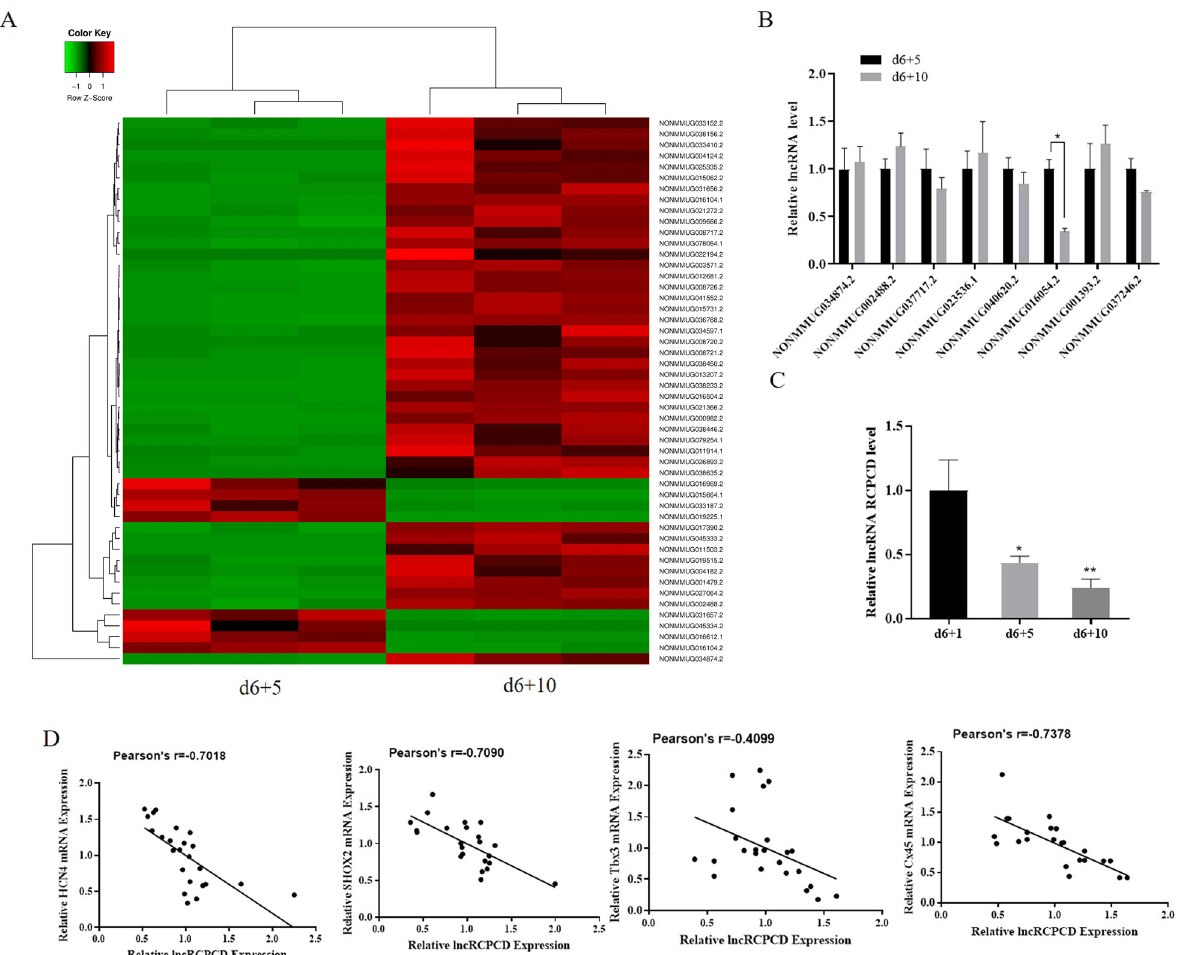
Fig. 2 LncRNA RCPCD involved in the differentiation of ESCs into pacemaker-like cells. A Heat map showing the differential expression of lncRNAs in differentiated ESCs at d6 + 5 and d6 + 10; B qRT-PCR was used to verify the differential expression of lncRNAs. C qRT-PCR detected the expression of lncRNA RCPCD in the differentiated ESCs at d6 + 1, d6 + 5, and d6 + 10. D Correlation analysis the expression of RCPCD and pacemaker-related genes in the differentiation of ESCs into pacemaker-like cells. * P < 0.05, ** P < 0.01, * as the difference that compared with the d1 cells. Error bars were represented the mean ± SD in triplicate